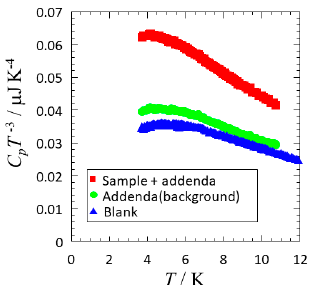
Figure 3. Temperature dependences of the total heat capacity of the sample part (red squares), addenda heat capacity (green circles), and blank heat capacity (blue triangles) shown in C p T − 3 vs. T plot.